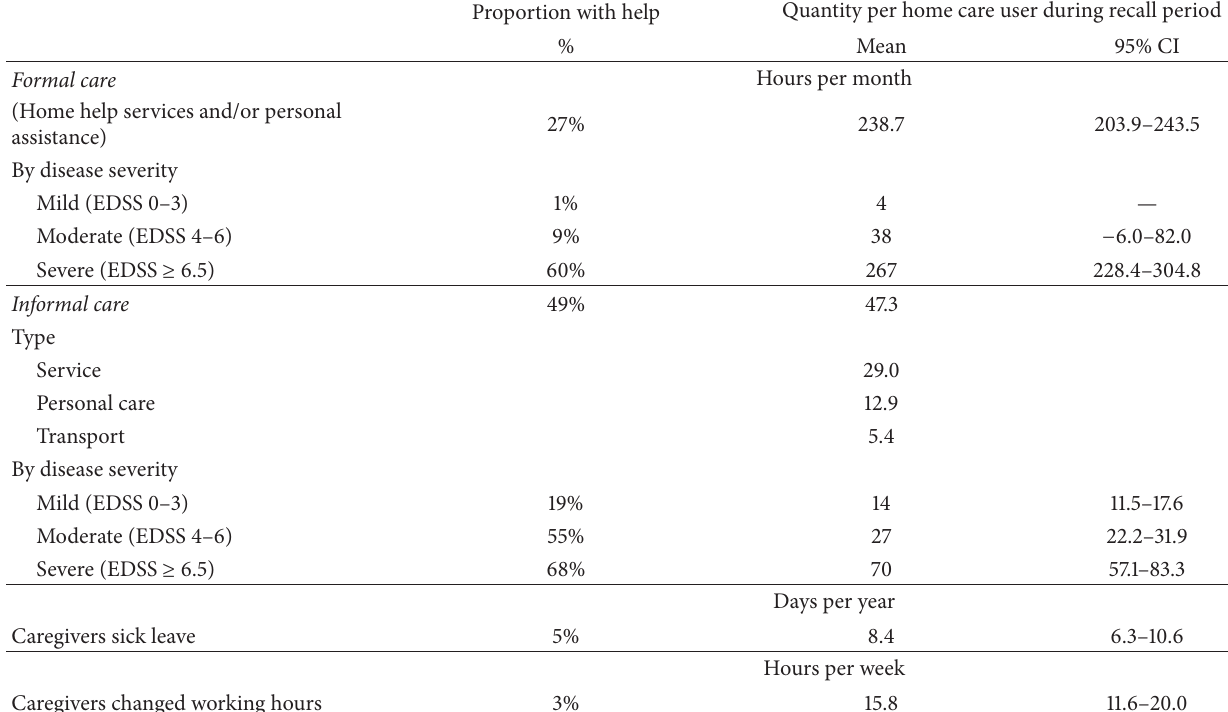
Table 3: Formal and informal care per home care